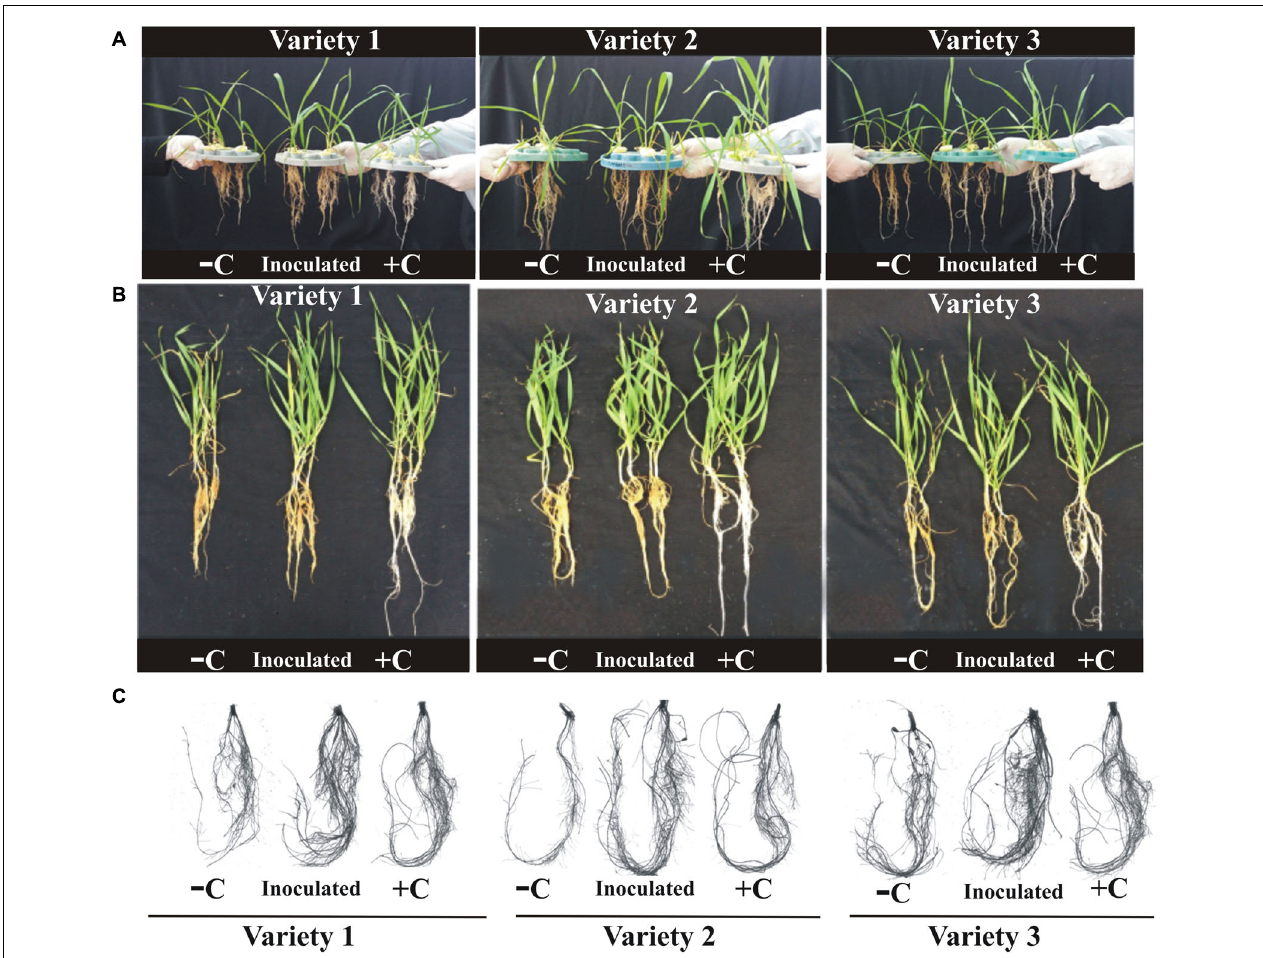
FIGURE 4 | Effect of PSB consortia on growth of hydroponically grown different wheat varieties (A,B) . Rhizoscanning shows the root architecture (C) . Data were recorded at 45 days of cultivation in hydroponic system. Uninoculated seeds were used as controls. Plants in six biological replicates were used to analyze different root parameters. DPI: Days post-inoculation; PSB: Phosphate-solubilizing bacteria; +C: uninoculated positive control; –C: uninoculated negative control; Variety 1: Faisalabad-08, Variety 2: Fakhr-e-Sarhad, Variety 3: Benazir-13.